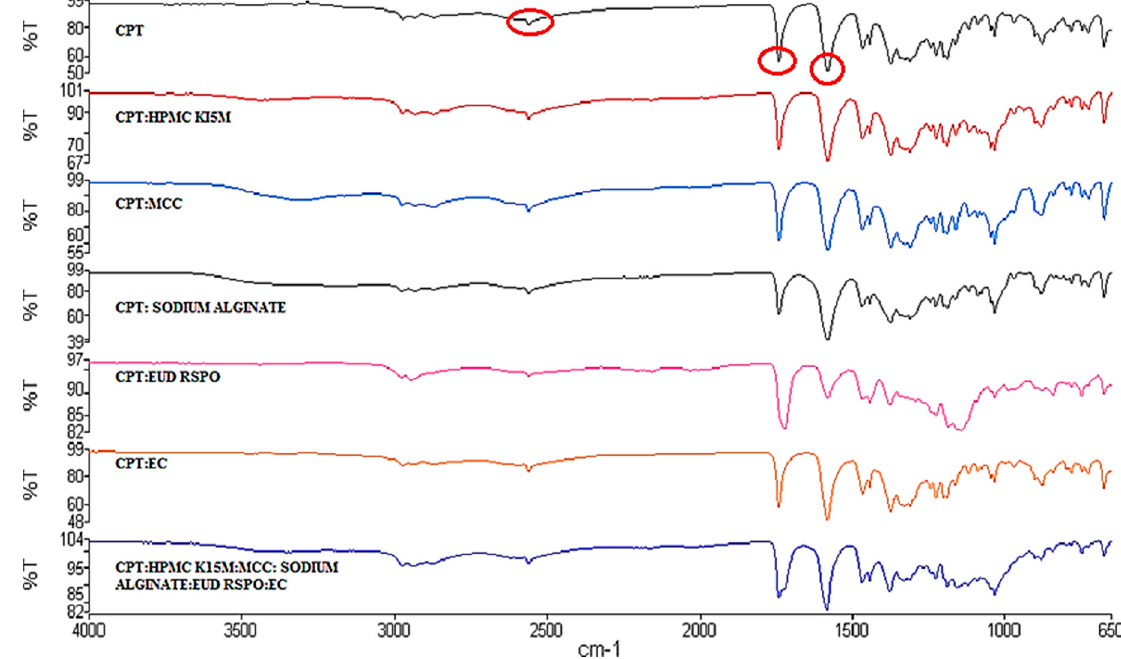
Figure 6. FTIR absorption spectra of CPT and 1:1 mixtures of CPT and potential excipients.